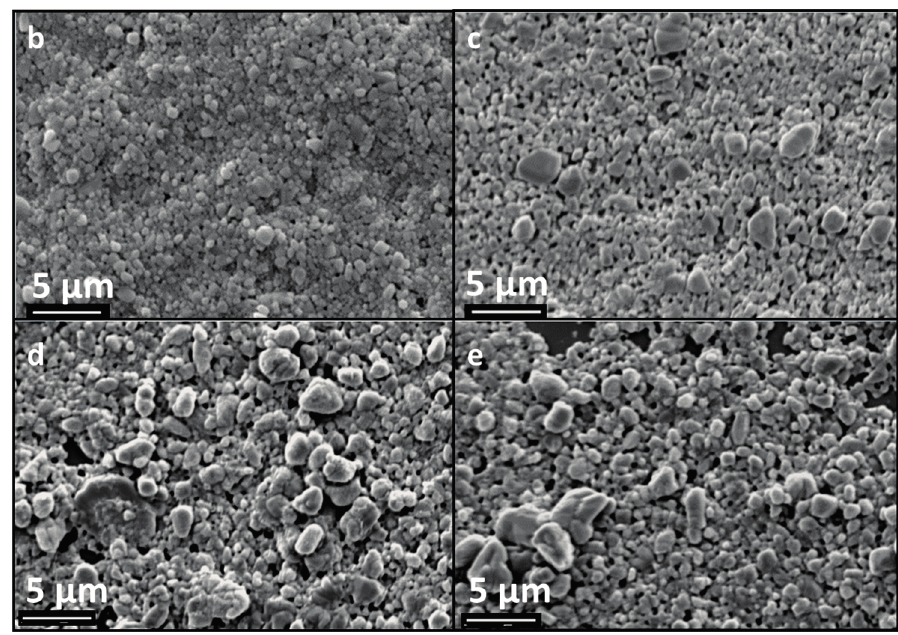
Figure 5. Scanning electron microscopy images of deposited HI 3 O 8 films: ( b ) drop casted; ( c – e ) spin coated at 500 rpm, 1500 rpm, and 2500 rpm. Films were deposited at ~2% relative humidity from a sonicated suspension of the as-received material in denatured ethanol. Note that figure labels used here correspond to the same samples and labels shown in Figure